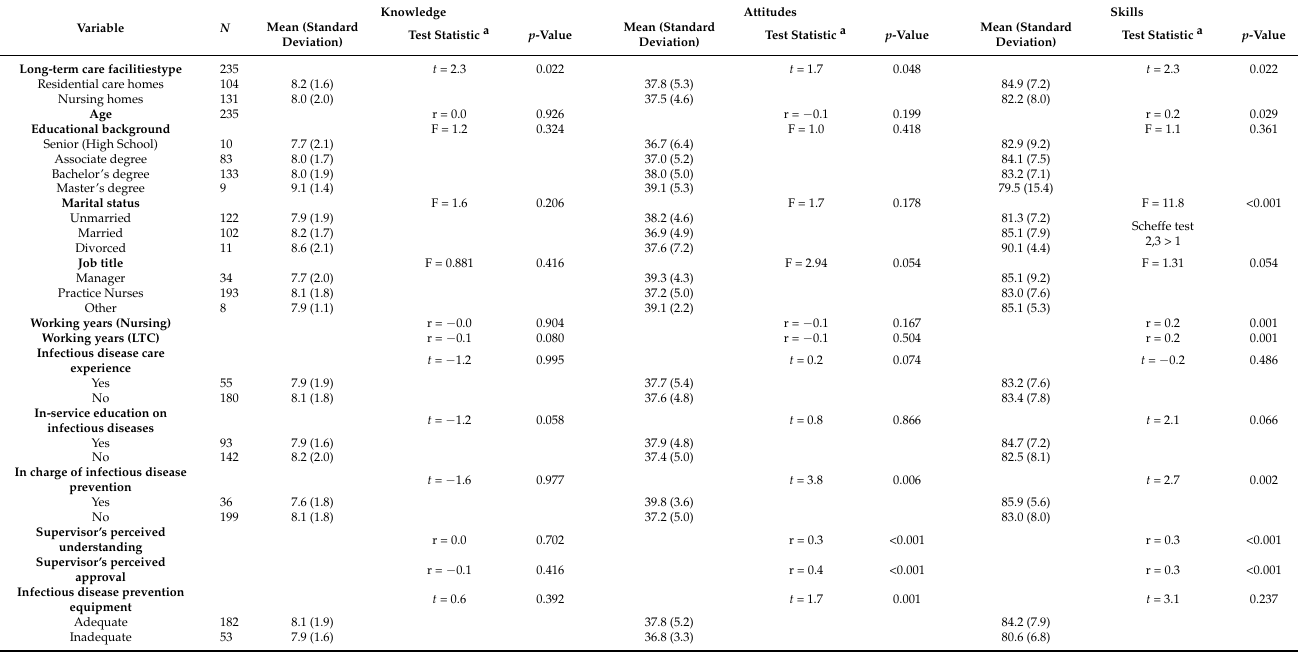
Table 3. Correlations among demographic attributes and EID prevention in long-term care facility nurses ( N = 235).